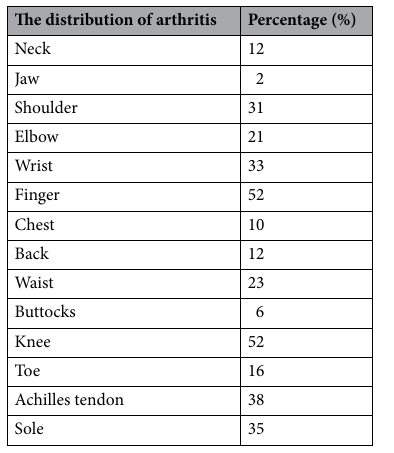
Table 1. The arthritis distribution. There is some overlapping in the distribution of